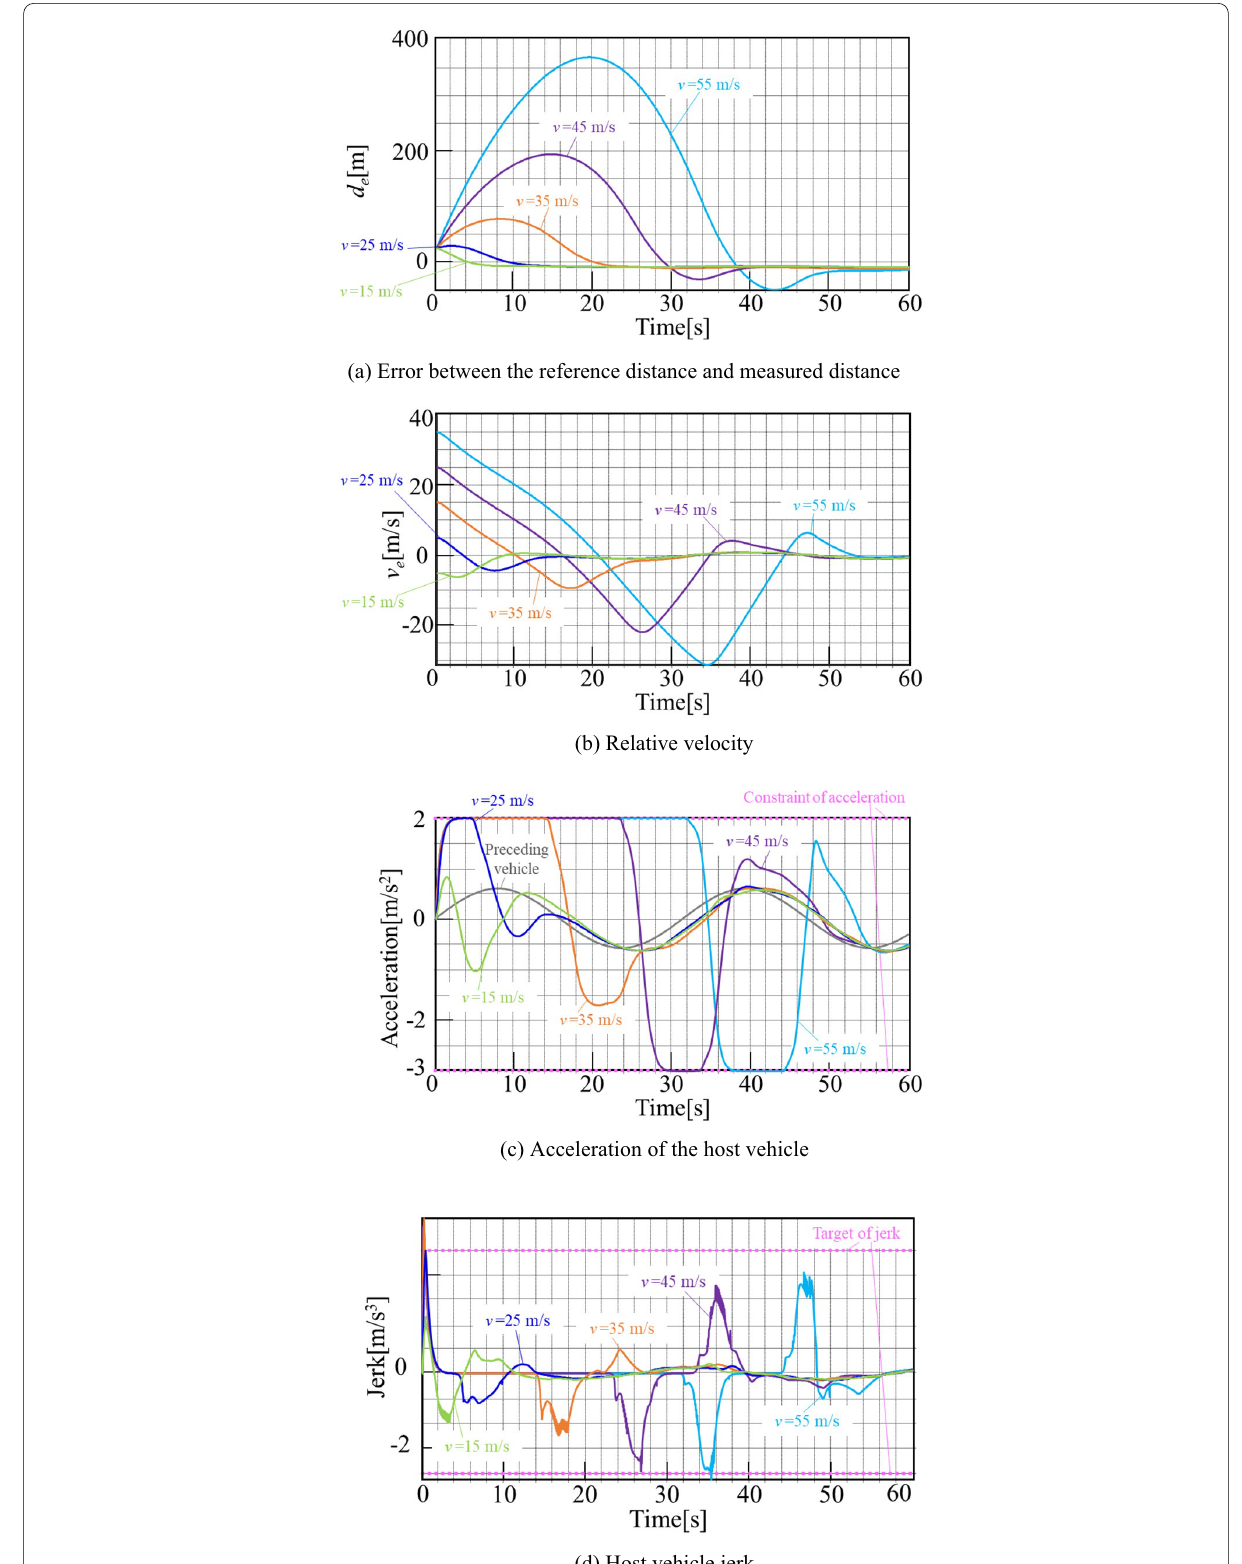
Fig. 5 (See legend on previous